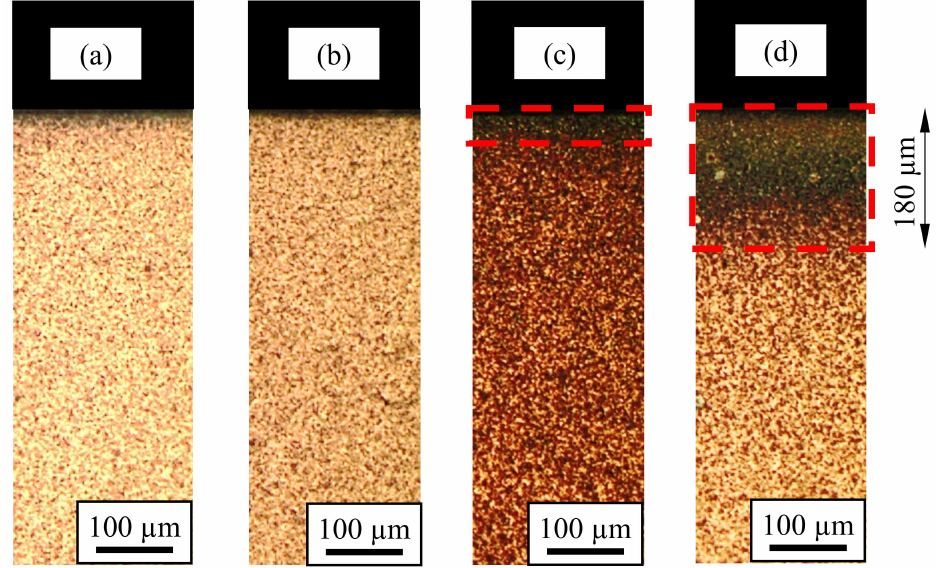
Figure 6. Microstructure beneath the machined surface after grinding with cutting fluid at different temperatures: ( a ) 5 ◦ C; ( b ) 10 ◦ C; ( c ) 15 ◦ C; and ( d ) room